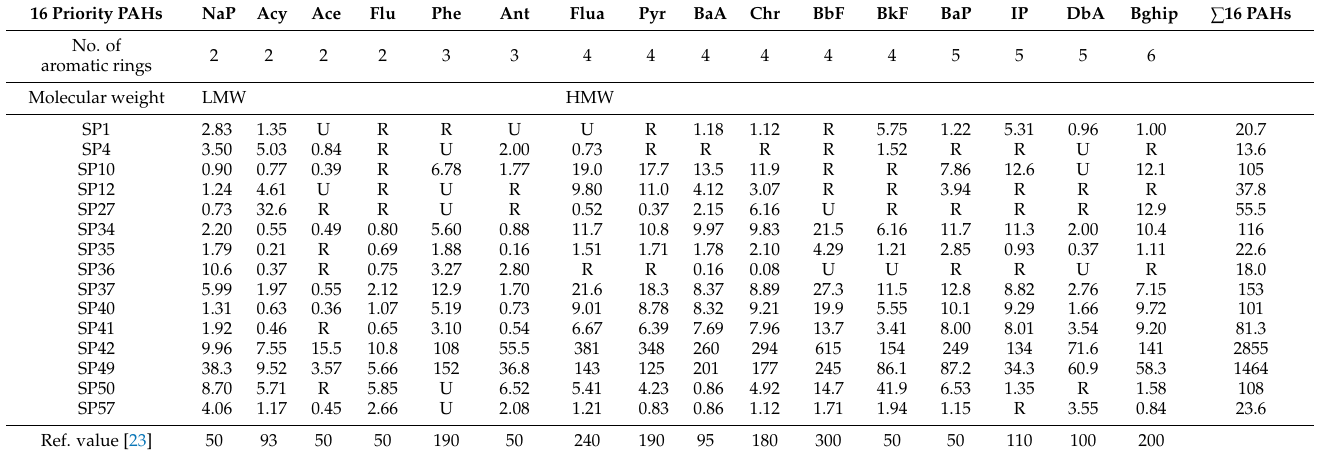
The concentration of the 16 priority PAHs in 15 soil samples surrounding the main waste pile in the São Pedro da Cova are presented in Table 7.